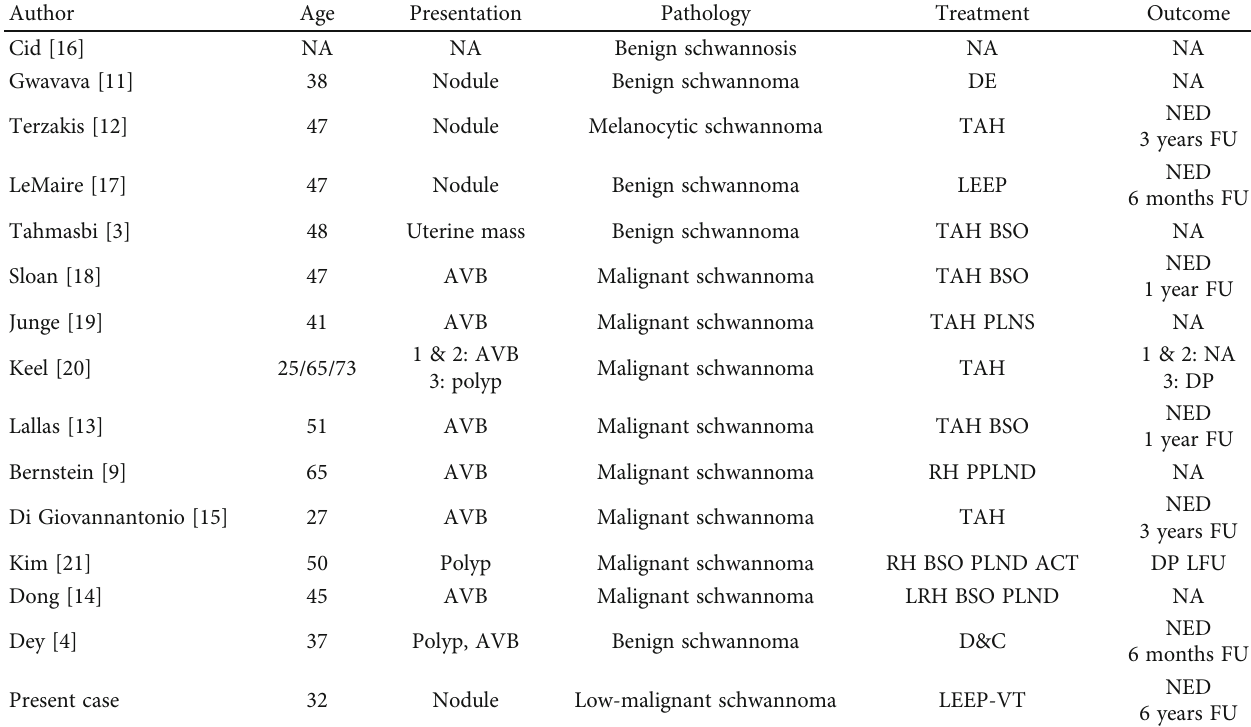
Table 1: Published cases of cervical